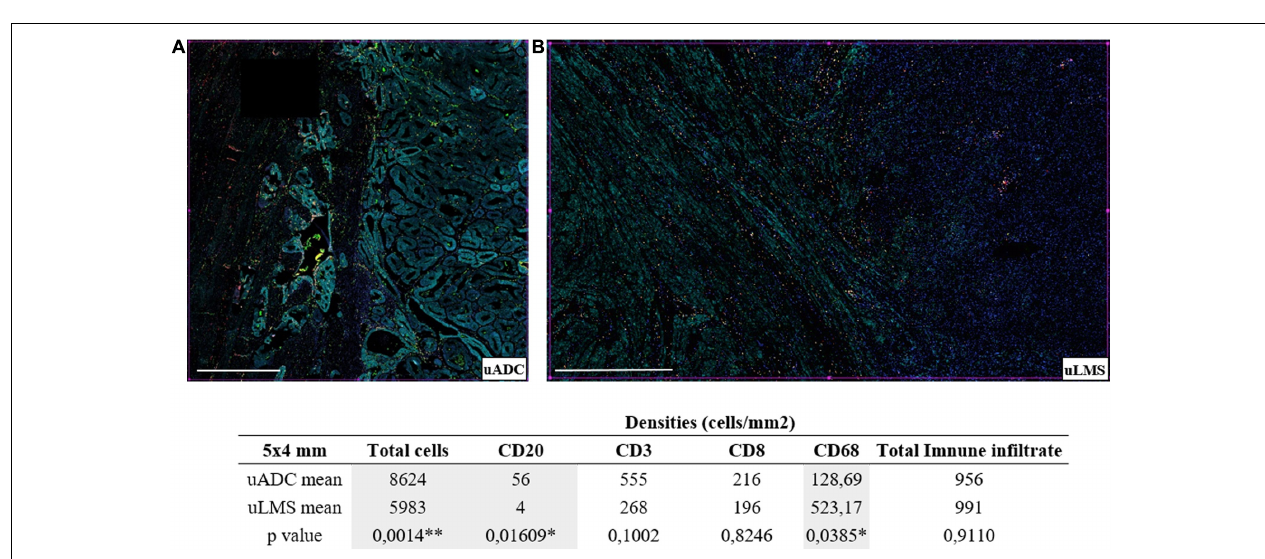
FIGURE 3 | Distinct immune infiltrate distribution at the invasive tumor front (ITF) of uterine adenocarcinomas (uADC) and leiomyosarcomas (uLMS). (A) Representative multiplex immunofluorescence images of approximately 5 × 4-mm regions of interest (ROIs) of an adenocarcinoma (uADC) (4 × 4) and a leiomyosarcoma (uLMS) (5 × 3 mm). Color code as follows: DAPI (blue), CD20 (yellow), CD68 (green), CD8 (red), CD3 (orange), cytokeratin (cyan). (B) The mean of the densities (number of cells/mm 2 ) for each cell marker is shown for uADC and uLMS as well as the mean for the total cells and the total immune infiltrate. Fisher–Snedecor test and Student T -test were applied for statistical comparison. P -values and significance ( ∗ < 0.05, ∗∗ < 0.01) for statistical comparison between the means of uADC and uLMS are displayed. Scale bars represent 1 mm.